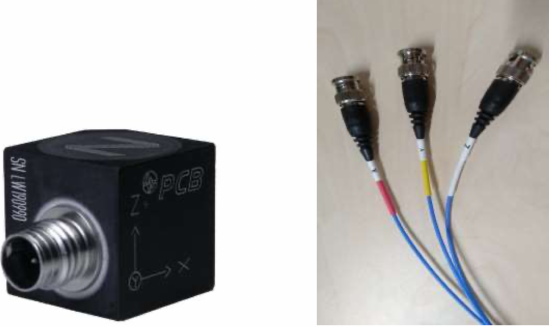
Figure 5. Triaxial accelerometers used in the testbed (PCB Piezotronics, model